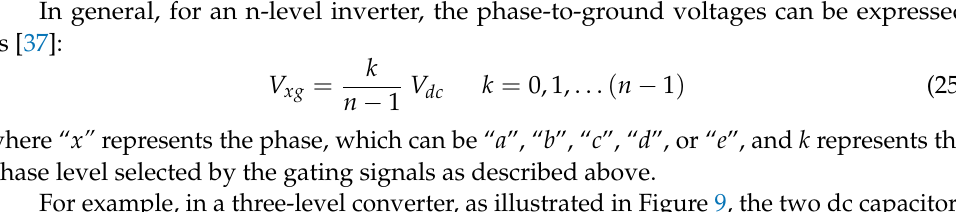
Figure 10. Four-level converter topology for a five-phase voltage source drive.